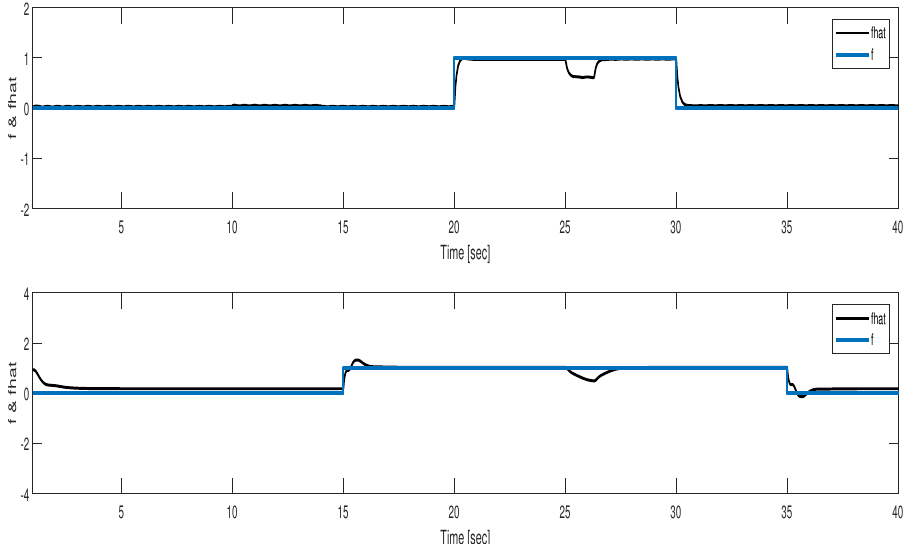
Figure 6. The simultaneous actuator and sensor fault reconstruction using the approach proposed in Theorem 5.